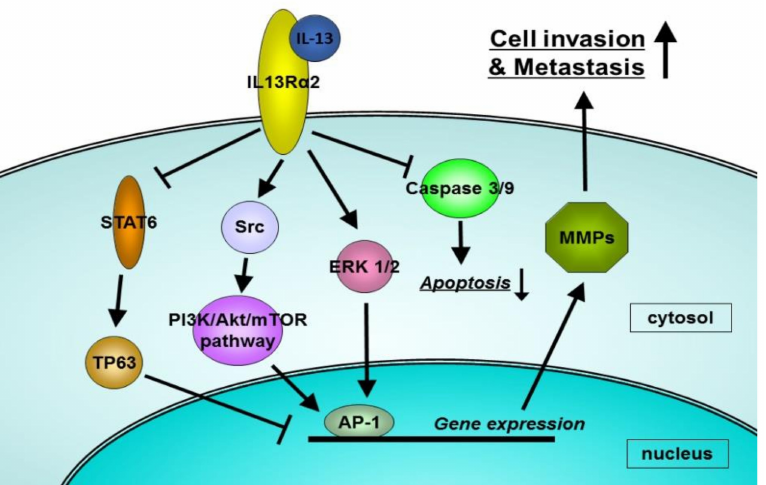
Figure 1. The schema of mechanisms by which IL-13R α 2 promotes cancer invasion of